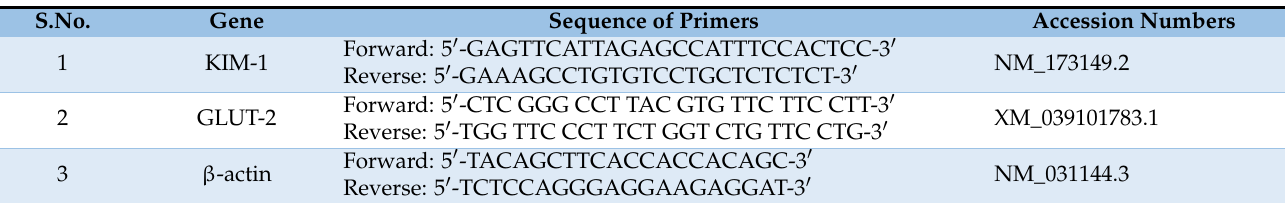
Table 1. Oligonucleotide primers for mRNA expression.